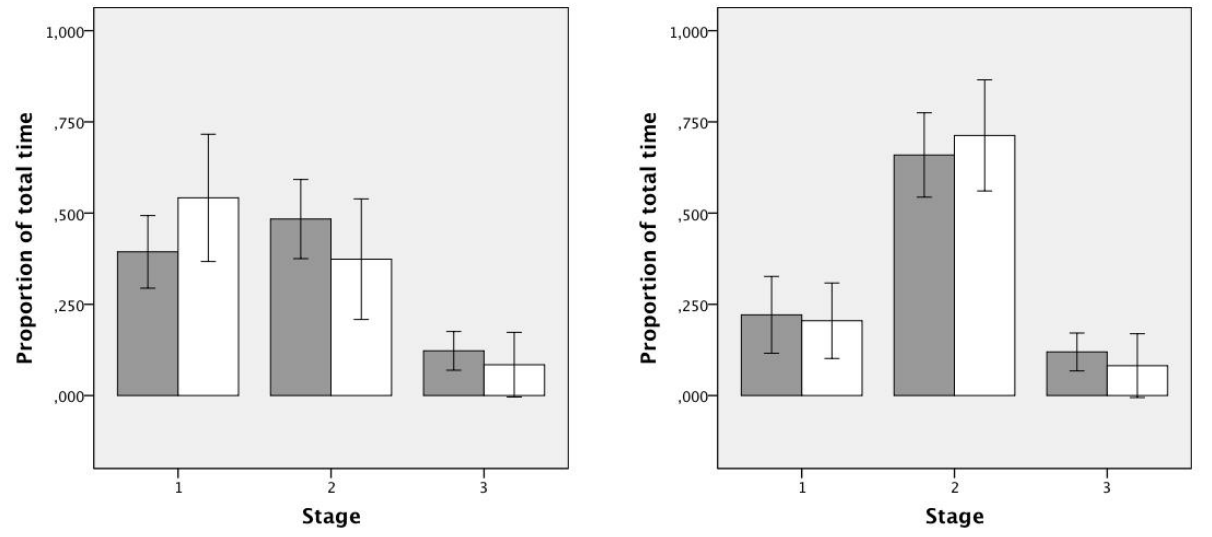
Figure 3. Proportion of total time, the Natural Decision Segmentation Model on the left, Russo and Leclerc (1994) version on the right. Grey bars represent decision task and white bars represent search task. Error bars +/- 2 SE.